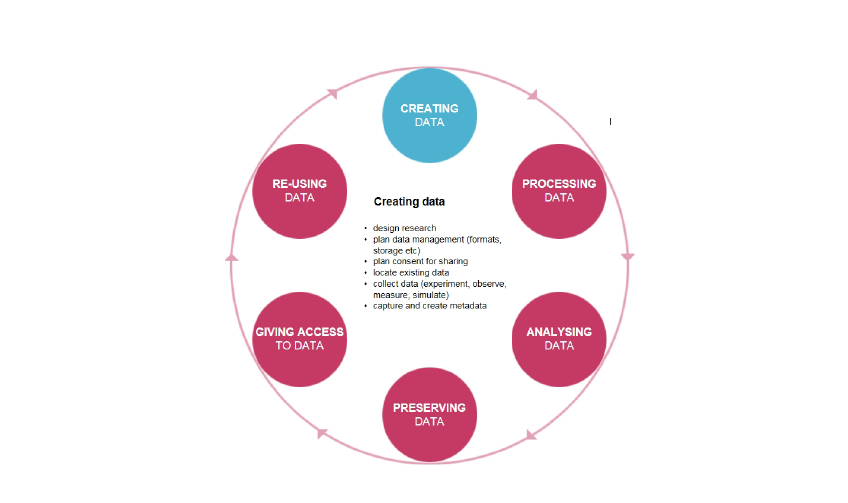
Figure 1. Data life cycle according to UK Data Archives - Posted by: Matthias Töwe, 21 / 04 /